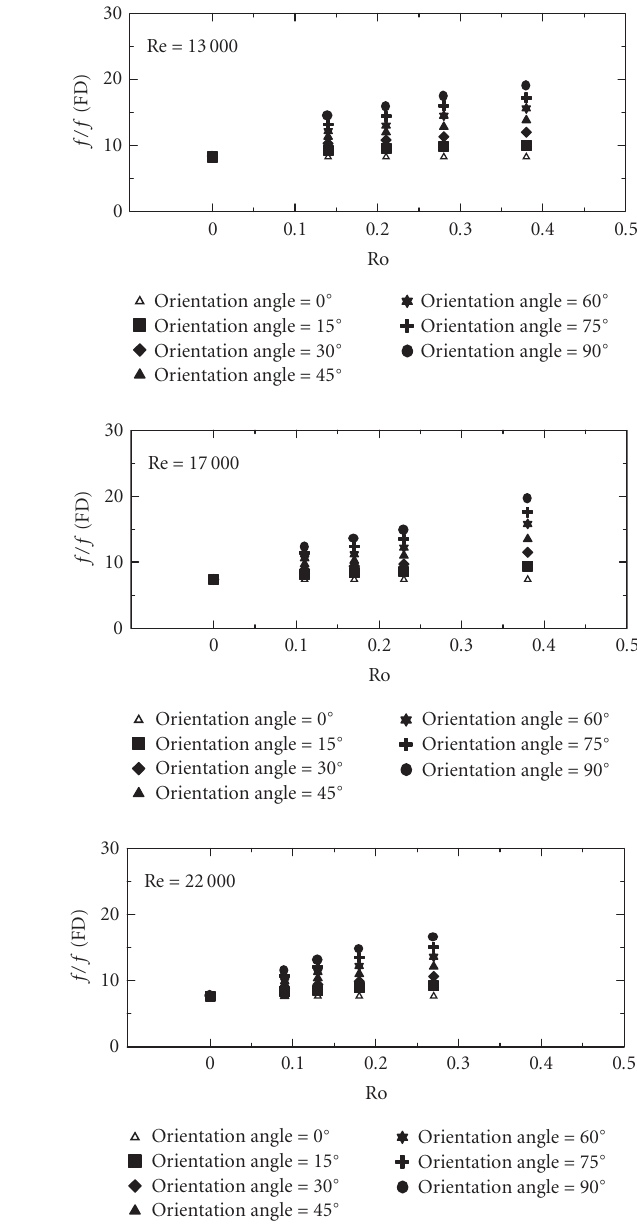
Figure 7: E ff ect of the orientation angle for 90 ◦ ribbed radial out- ward flow channel of a rib pitch-to-height ratio of 10,5.